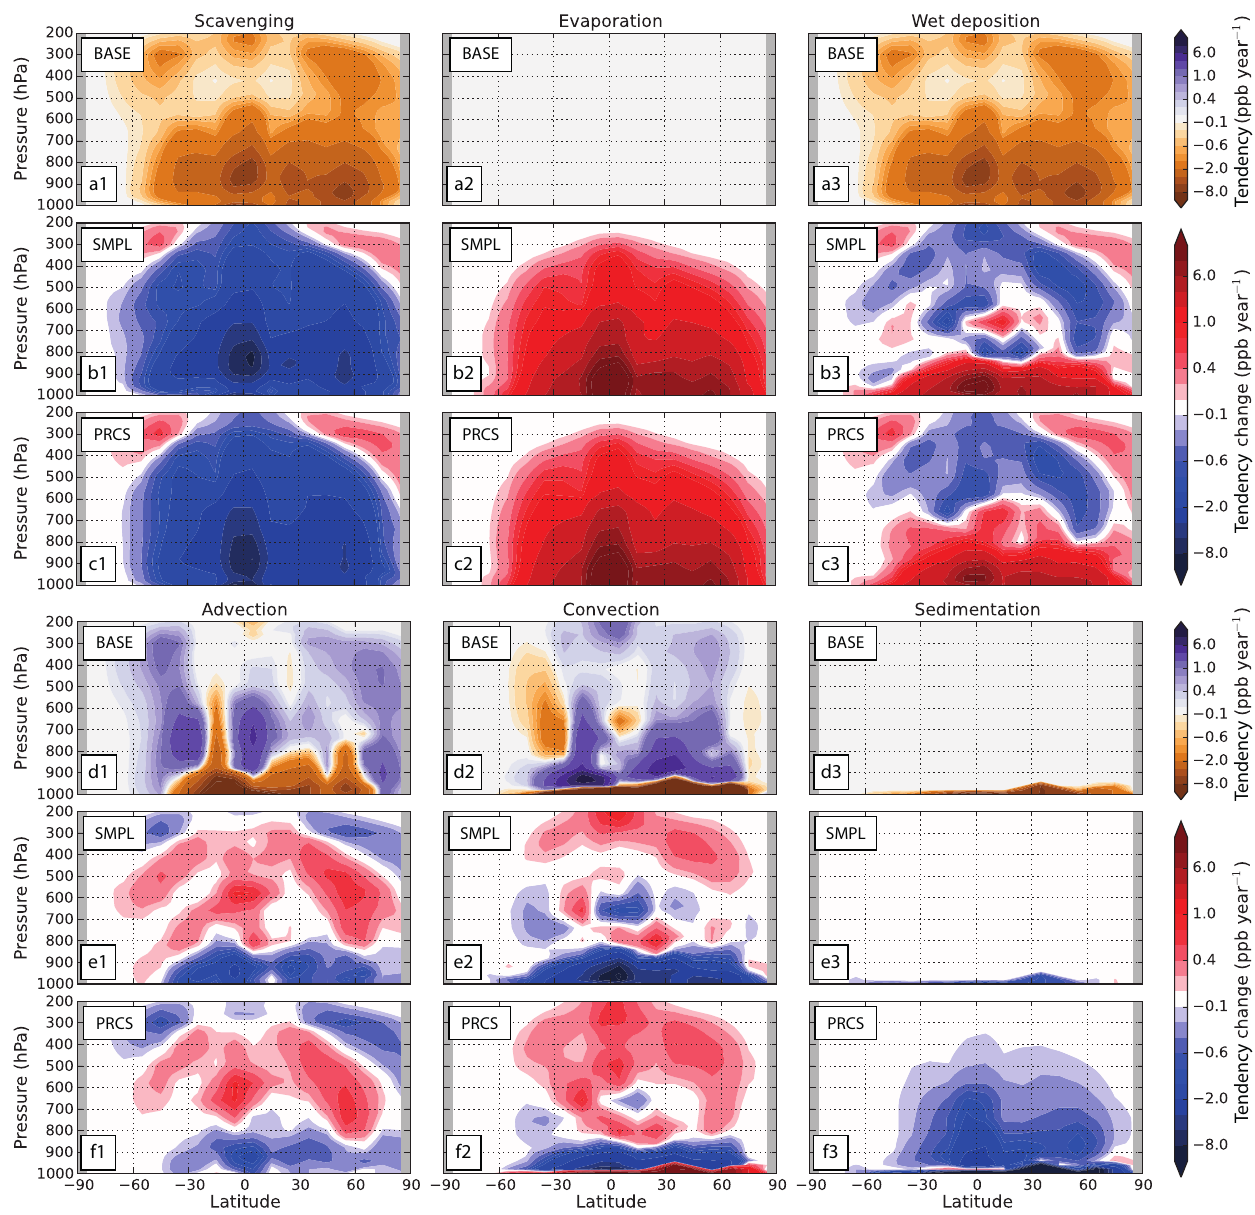
Figure B1. Zonal average distribution of local tendency in particulate organic matter (POM) in ppbyear − 1 caused by large-scale scavenging, evaporation, wet deposition (scavenging plus evaporation), advection, convection and sedimentation. General patterns are shown for the BASE simulation (a, d) where positive (negative) values indicate a local source (sink) by the respective process. Differences compared to these BASE patterns are shown for the SMPL (b, e) and PRCS (c, f) simulations. Positive (negative) differences indicate a weaker (stronger) local removal or stronger (weaker) local